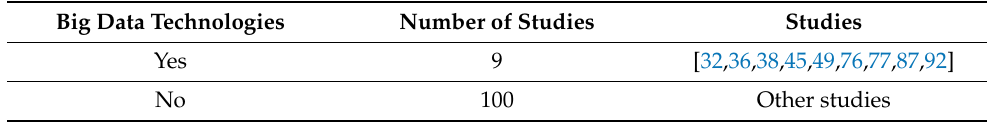
Table 2. Big data